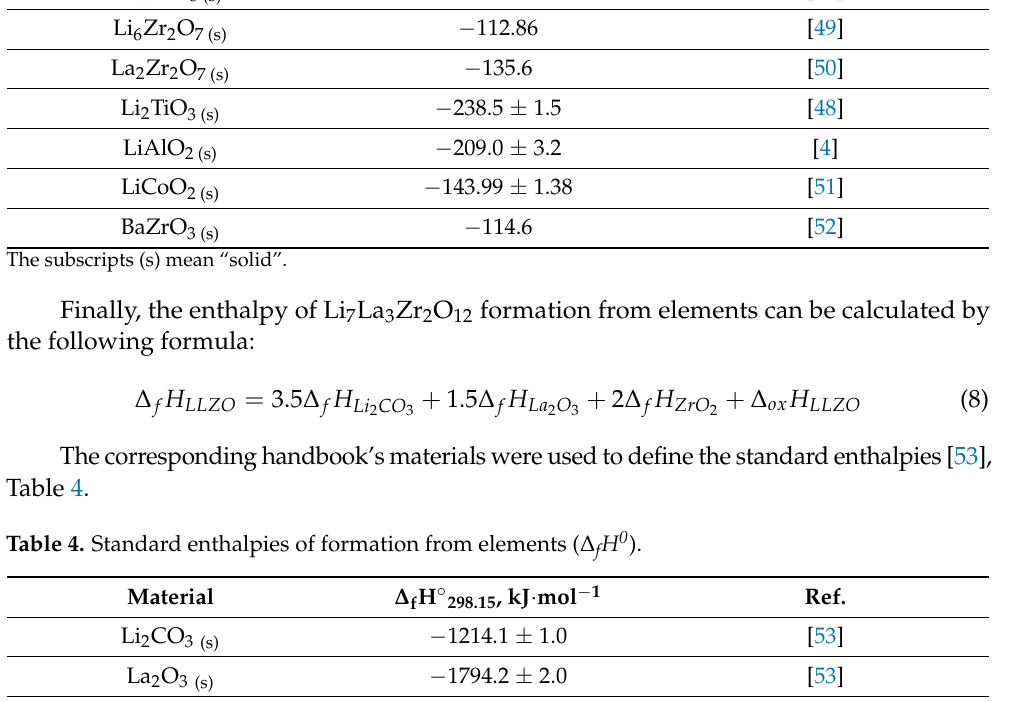
Table 3. Standard enthalpies of formation of complex oxides from binary oxides ( ∆ ox H 0 ). Compound ∆ ox H ◦ 298.15 , kJ · mol − 1 Reference Li 7 La 3 Zr 2 O 12 (s) − 186.4 ± 7.3 this work Li 2 ZrO 3 (s) − 304.1 ± 1.4 [48] Li 6 Zr 2 O 7 (s) − 112.86 [49] La 2 Zr 2 O 7 (s) − 135.6 [50] Li 2 TiO 3 (s) − 238.5 ± 1.5 [48] LiAlO 2 (s) − 209.0 ± 3.2 [4] LiCoO 2 (s) − 143.99 ± 1.38 [51] BaZrO 3 (s) − 114.6 [52]